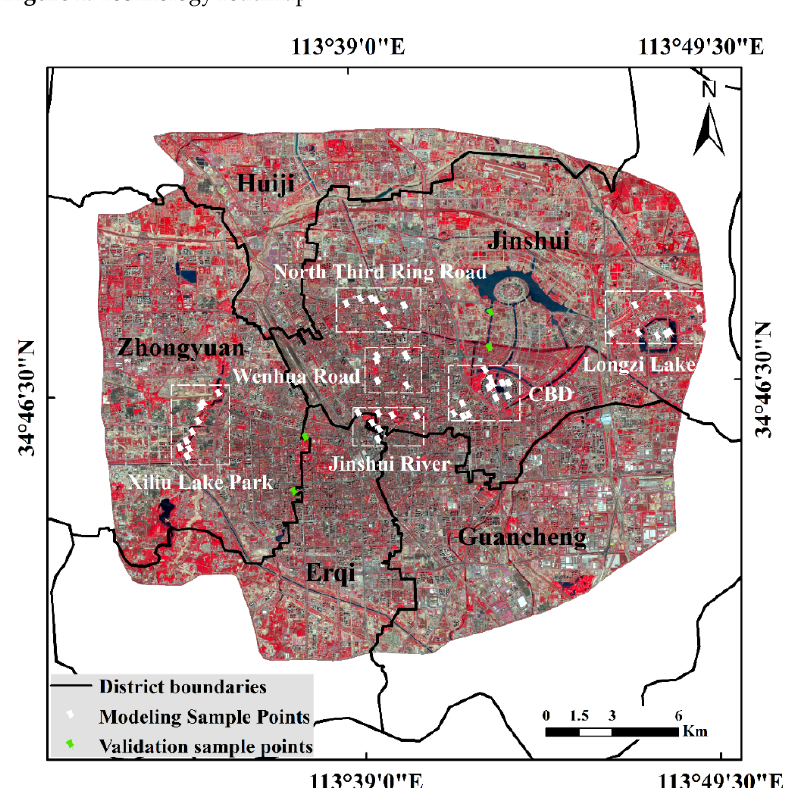
Figure 3. Spatial distribution of sampling stations.